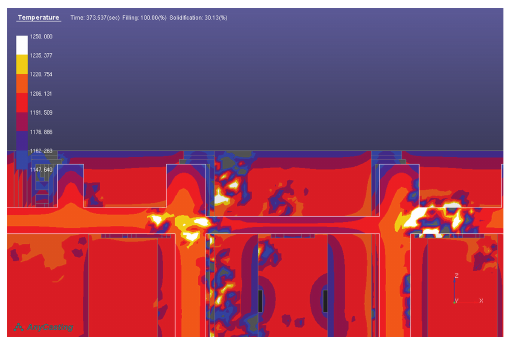
Figure 16: Temperature variation during alloy solidification. Section in the defect zone.